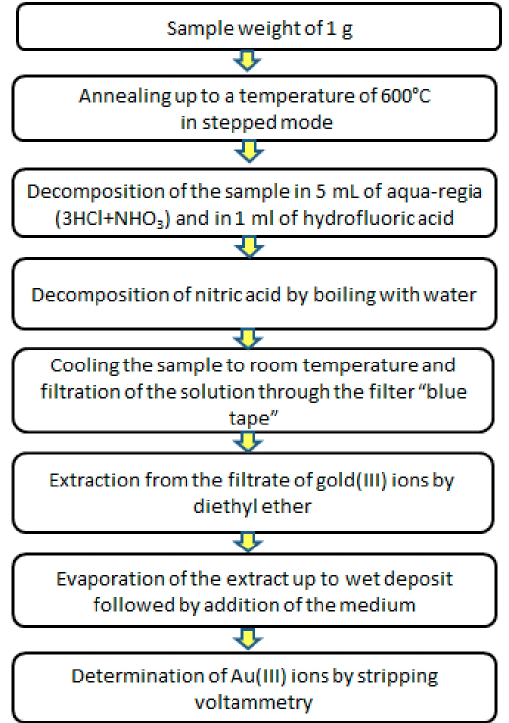
Figure 9. A scheme of sample preparation to determine gold(III) ions.